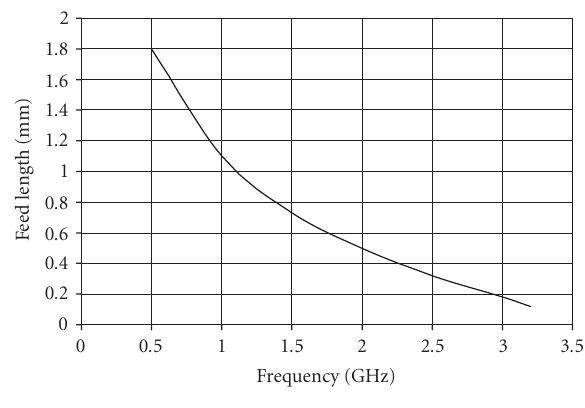
Figure 3: Variation of feed length p with lower band-edge frequency f L for PCMA and PEMAs.